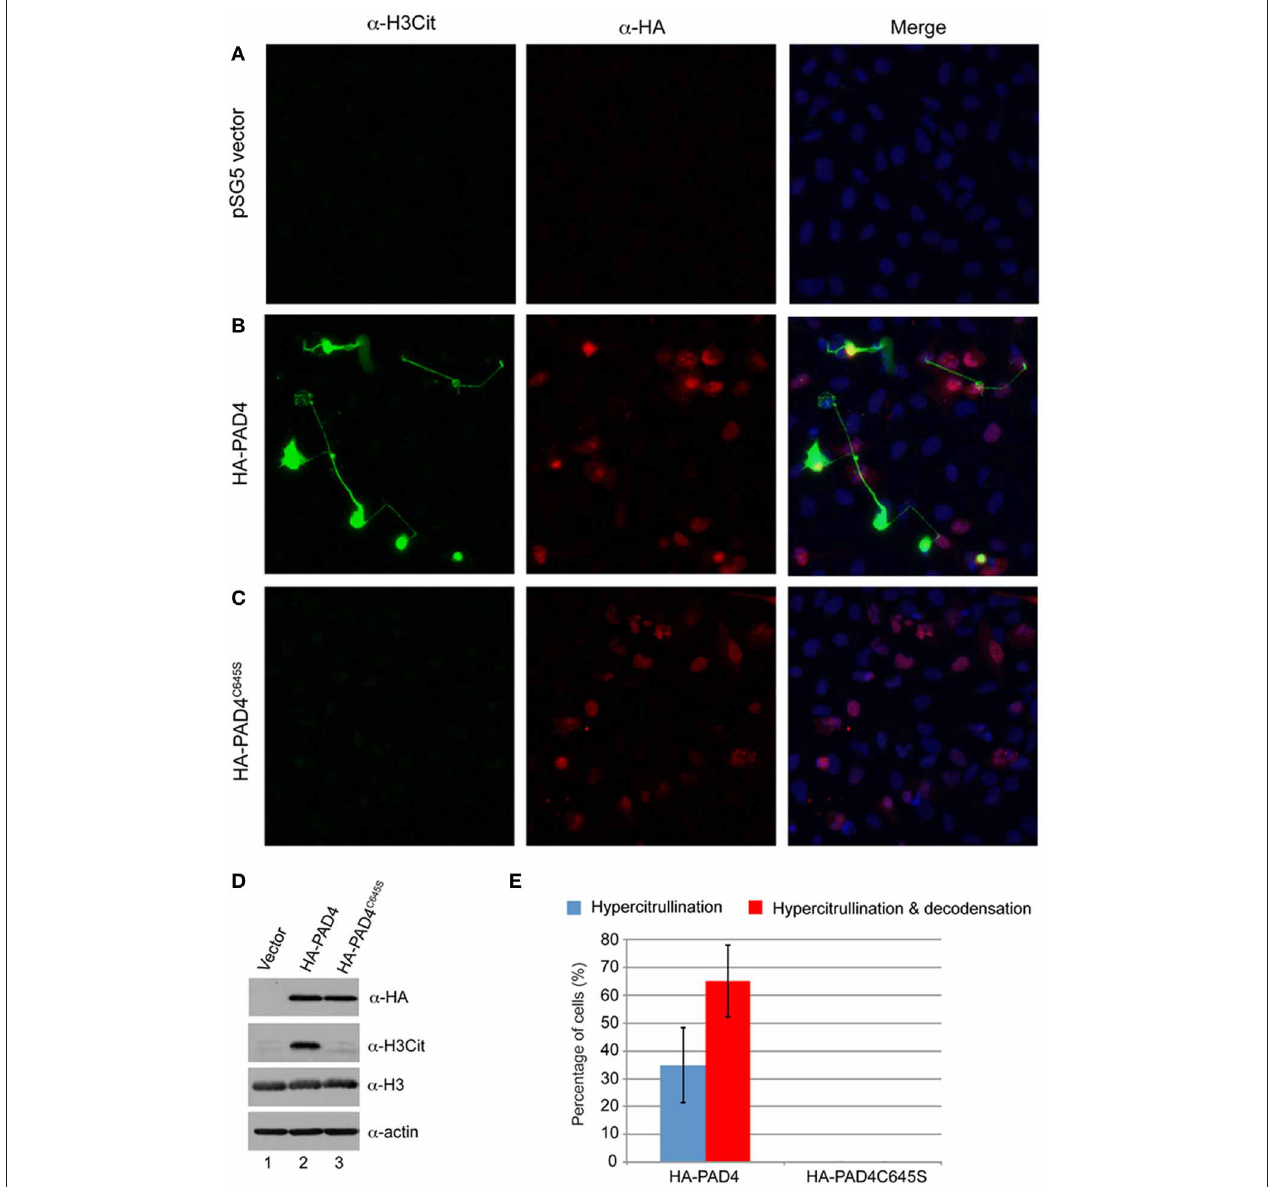
FIGURE 3 | PAD4 activity is important for the induction of NET-like structures. (A–C) Fluorescent microscope analyses of histone H3Cit and chromatin morphology in U2OS cells transfected with the pSG5 vector, the pSG5-HA-PAD4 plasmid, or the pSG5-HA-PAD4 C645S plasmid. (D) Western blot analyses of HA-fusion protein expression, histone H3Cit levels in U2OS cells after transient transfection. Histone H3 and actin were